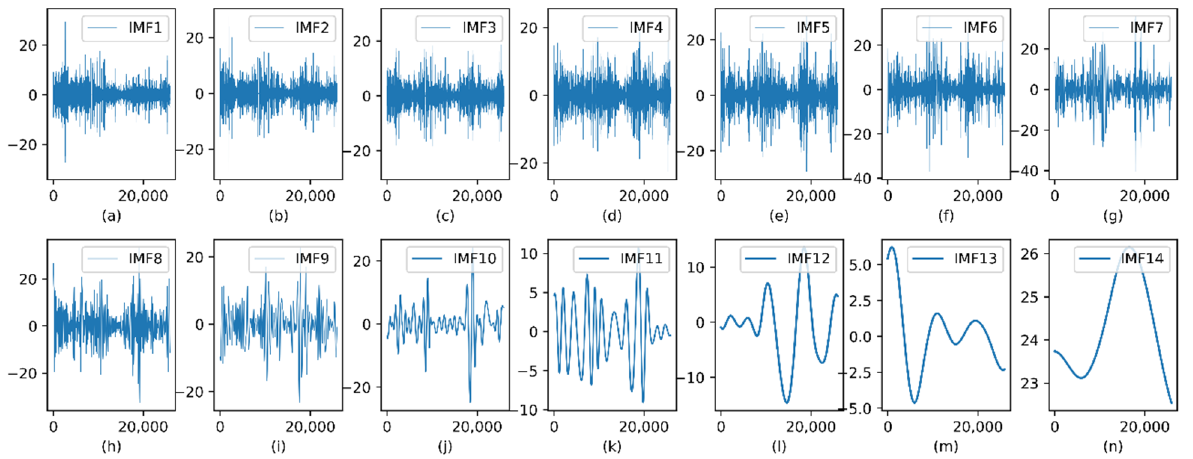
Figure 3. CEEMDAN modal decomposition wave IMFi : ( a – n ) represent IMF 1 – IMF 14 .